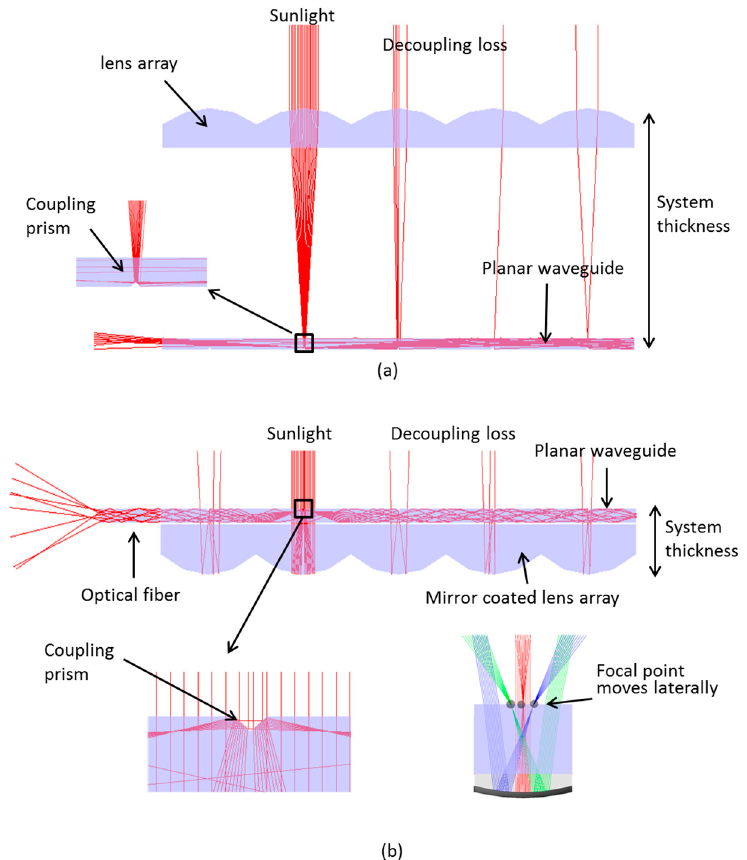
Figure 1. ( a ) Principles of a conventional planar waveguide concentrator; ( b ) Our proposed flat optical fiber daylighting systems (OFDS) which allows using lateral displacement Sun-tracking mechanism.